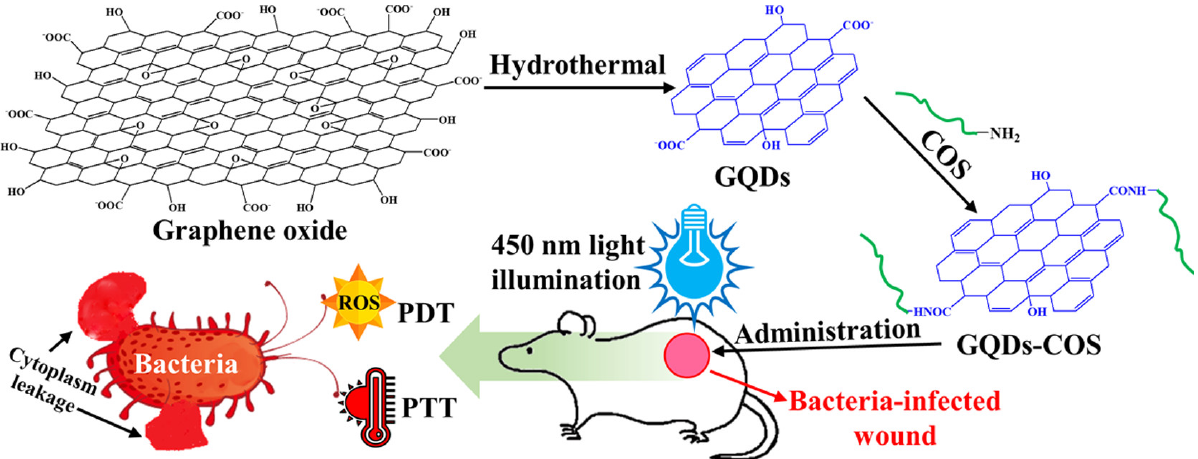
Figure 3. Schematic illustration of graphene quantum dots (GQDs)-chitosan oligosaccharide (COS) synthesis and its PTT- and PDT-based synergistic antibacterial wound healing. Reproduced with permission from Ref. [49]. Copyright 2020 American Chemical Society.